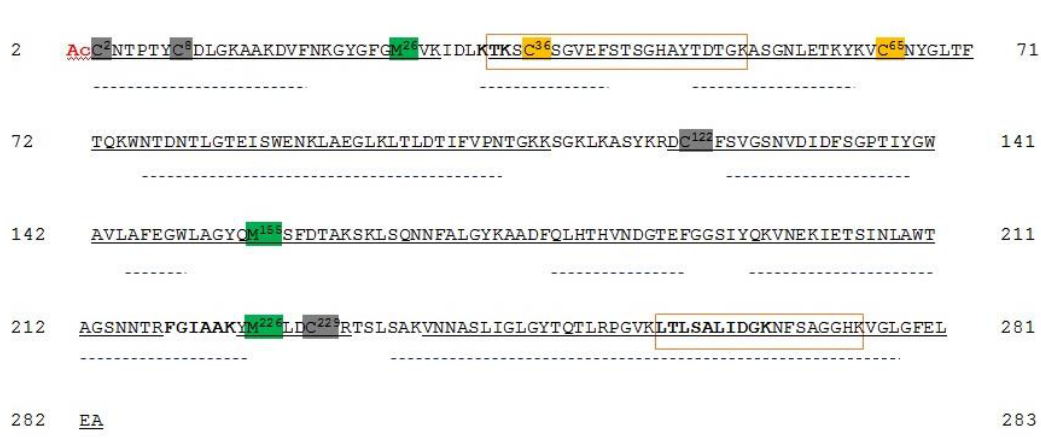
Figure 5. Sequence coverage map of hVDAC3 obtained by tryptic and chymotryptic digestion. The gray solid line indicates the sequence obtained with tryptic peptides; dotted lines the sequence obtained with chymotryptic peptides. The carboxyamidomethylated cysteine residues are highlighted in grey, and the partially oxidized cysteine residues are highlighted in orange. The partially oxidized methionine residues are highlighted in green. The acetyl group linked to the N-terminal cysteine is shown in red. Unique tryptic peptides originated by missed-cleavages were used to distinguish and cover sequences shared by isoforms: they are indicated in the boxes. Sequences that are shared by more isoforms are reported in bold. Numbering of the sequence considered the starting methionine residue, actually deleted during protein